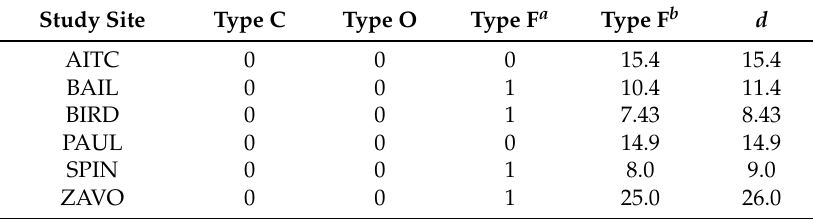
Table 10. A site-wise summary of type and total amount of deviation required for adaptation.